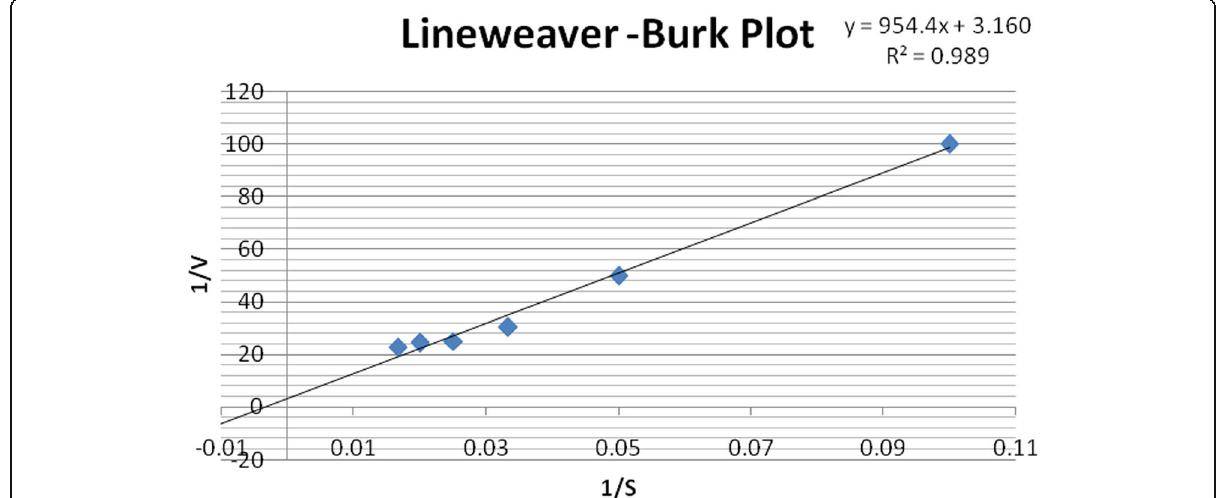
Fig. 9 Double reciprocal plot to show the kinetic parameters of purified lipase from the larval fat body tissue of G. mellonella by using PNPB (from 10 to 60 mM) (1/V max = intercept on the 1/V 0 ordinate, K m/ V max = the slope of the regression